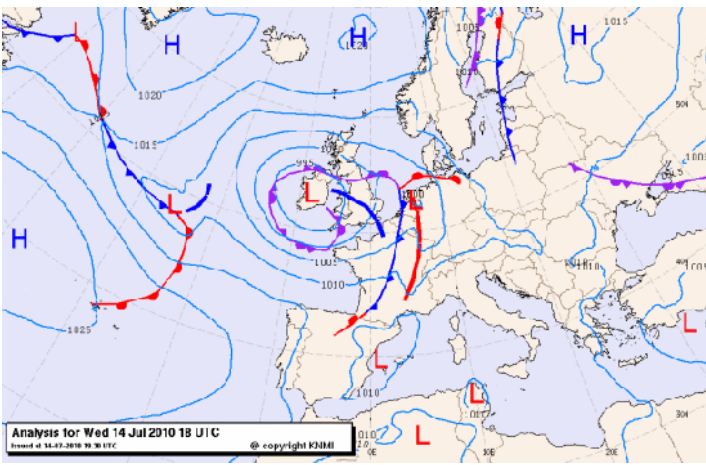
Figure 9. Weather chart of 14 July 2010, 18:00UTC. The chart shows the low-pressure system south of Ireland and the cold front, displacing the warm continental air with cooler air from the Bay of Biscay, as a blue line with closed triangles.